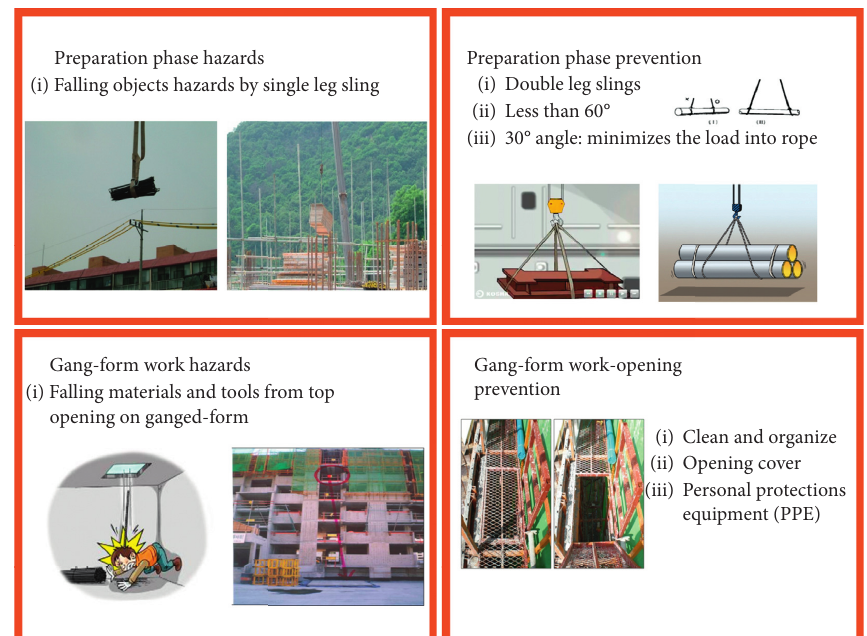
Figure 1: Examples of conventional safety training slides.